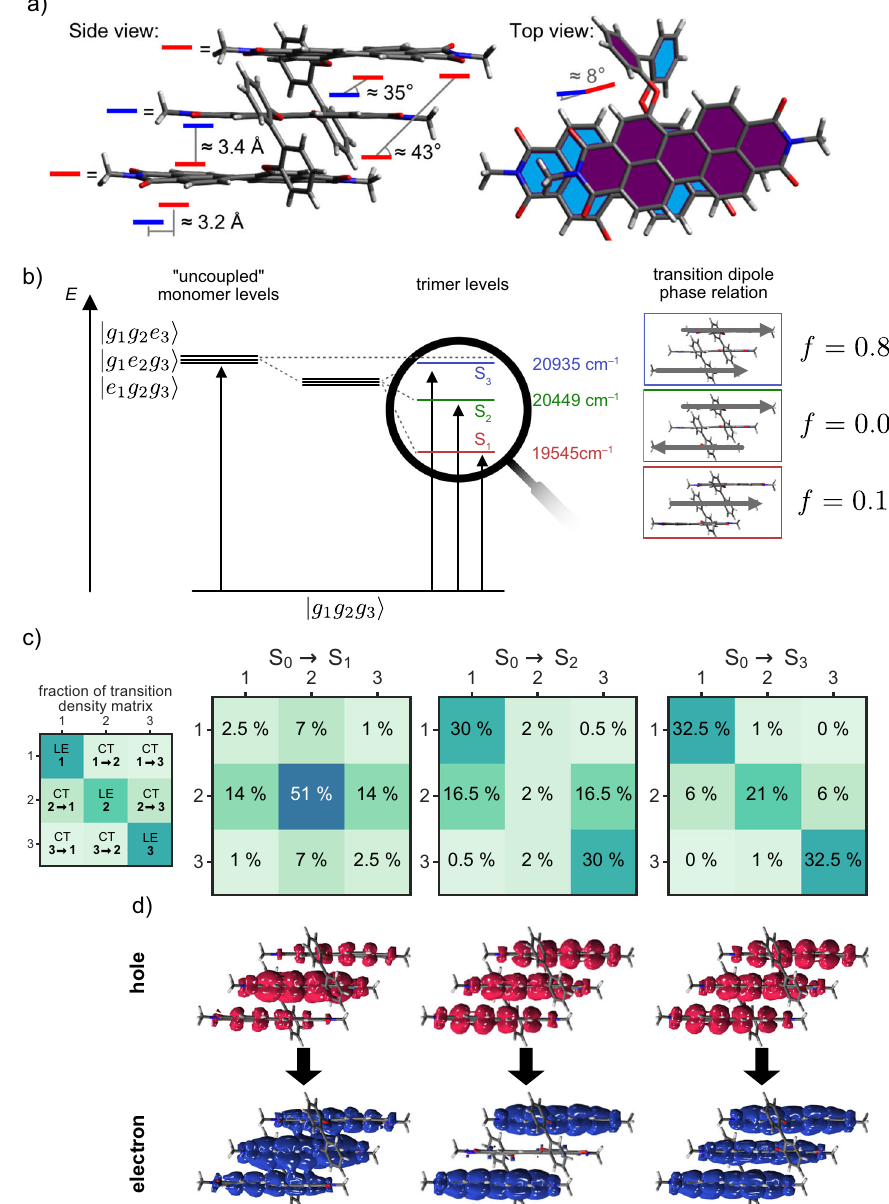
Fig. 2 | X-ray crystal structure and exciton coupling of Tris-PBI. a Molecular structureof Tris-PBI insinglecrystalswith2-hexyldecylgroupsreplacedbymethyl groups for clarity. b calculated optical transitions with transition dipole phase relation(excitoncoupling)forthecrystalstructure.The g and e indicatetheground andexcitedstates,respectively.Energiesandoscillatorstrengthsareobtainedfrom